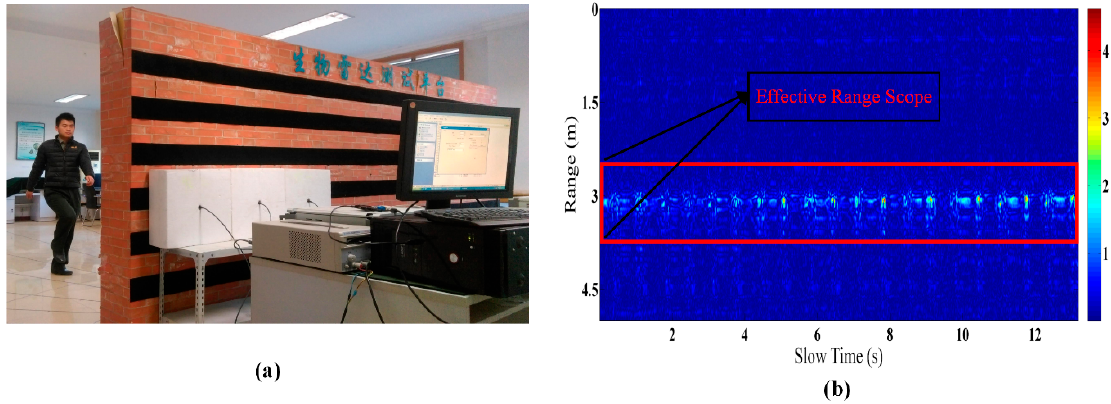
Figure 2. ( a ) Through-wall detection of human activity. ( b ) Preprocessed SFCW radar signal of piaffe-type movement.